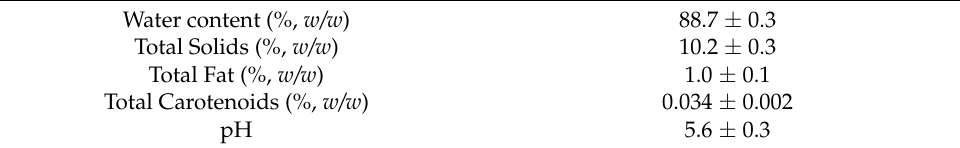
Table 1. Physicochemical composition of LTW used for the CPE